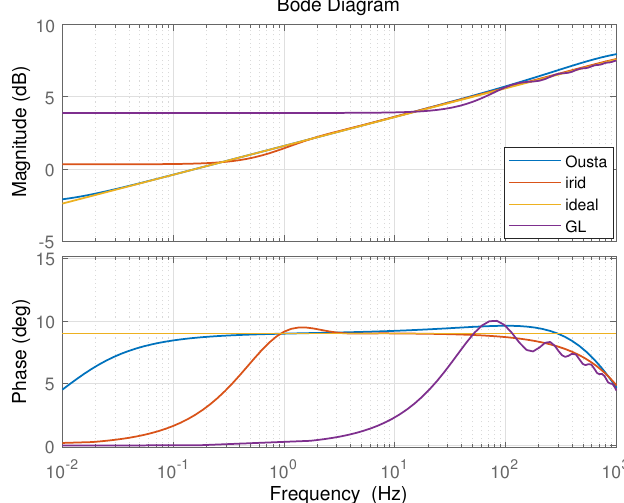
Figure 7. Case 4: 24th order discretization approximate Bode graph of s 0.1 in the frequency band [0.01, 1000]Hz.